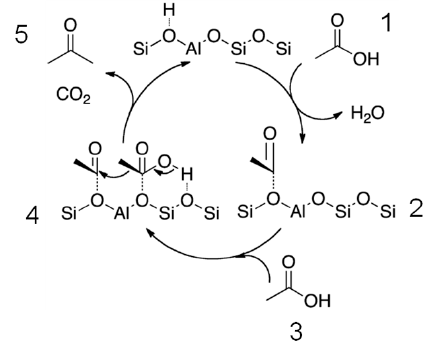
Figure 2. Proposed mechanism for acetic acid ketonisation to acetone over zeolites. Reproduced with permission from reference [47], Copyright © 2016, Elsevier.